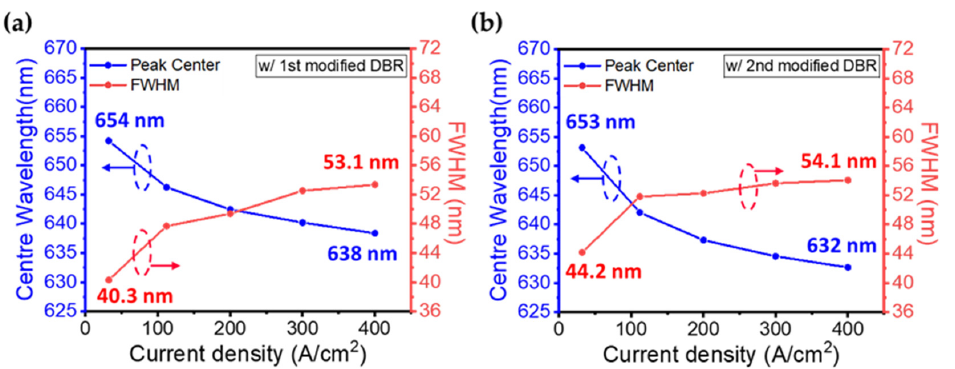
Figure 5. Centre wavelength and FWHM of EL emission as a function of current density for the InGaN red micro-LEDs ( a ) with the 1st modified DBR and ( b ) with the 2nd modified DBR.